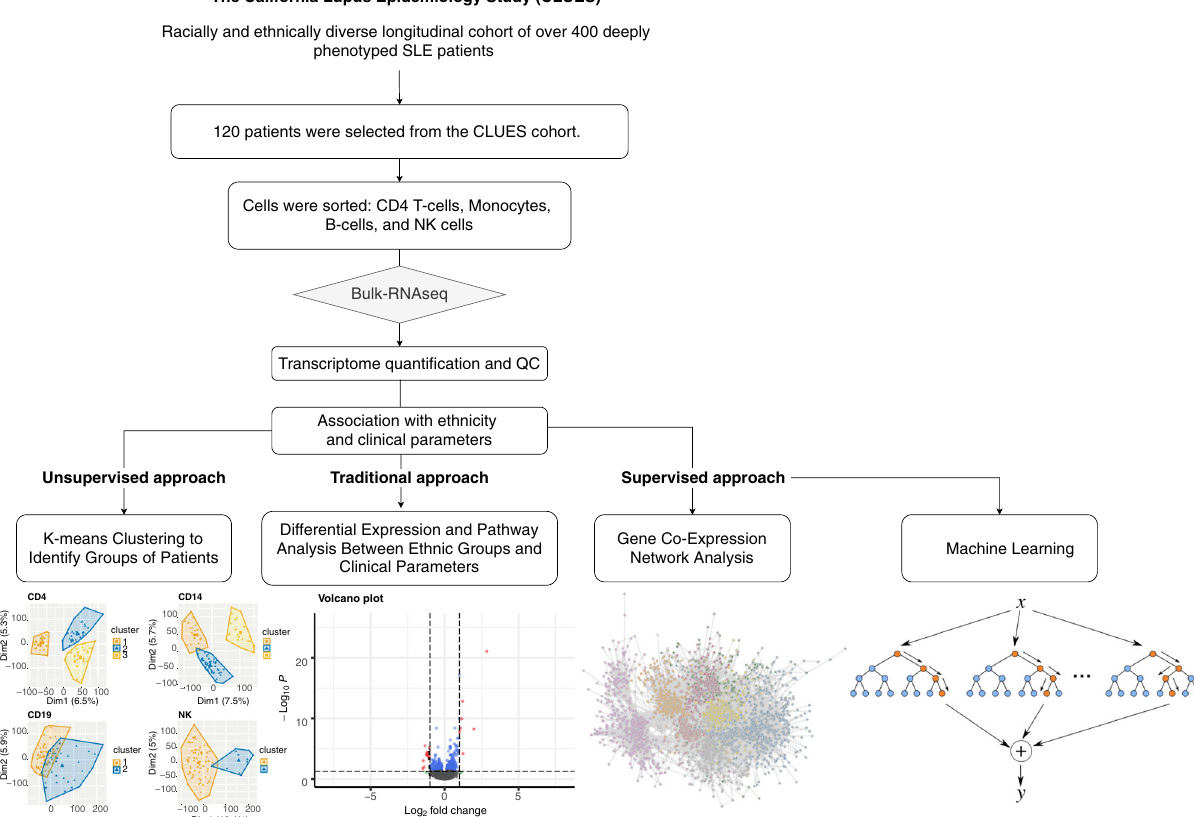
Fig. 1 Targeted tier approach. 120 patients were selected for bulk RNA-seq analyses from the CLUES cohort (Supplementary Data 1). Data were QC ’ ed and processed for transcriptome quanti fi cation (Supplementary Fig. 1). After removal of the outliers/low-quality samples, we used three types